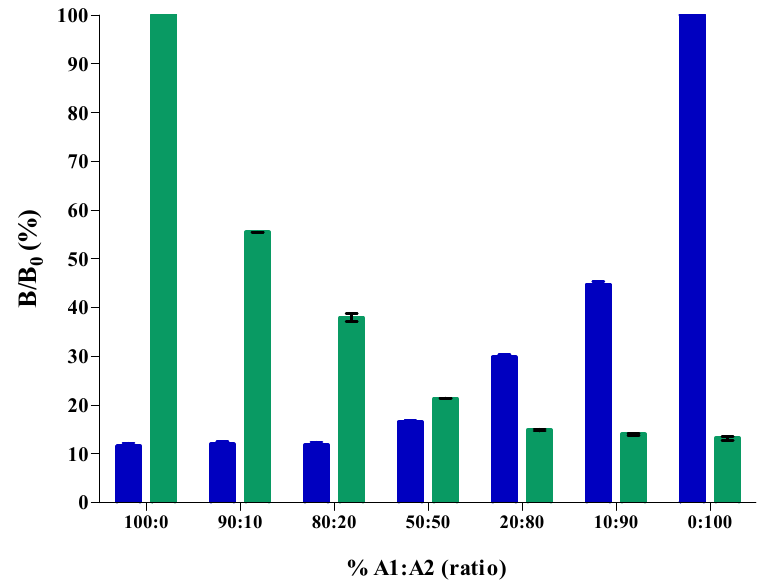
Figure 5. Dose-response results (B/B 0 (%)) for different ratios of A1A1/A2A2 milk mixtures in the competitive microsphere multiplex immunoassays detecting both β CA1 ( ■ ) and β CA2 ( ■ ).